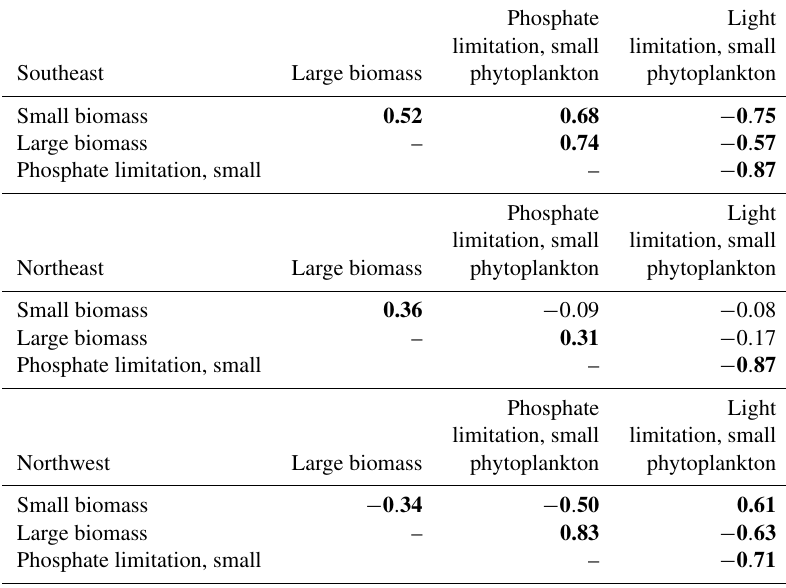
Table 1. Correlations of phosphate and light limitation for small phytoplankton to large and small biomass, 1949–2009. For conciseness, shown here are only small phytoplankton limitation terms, but since these are ratios calculated from identical fields, the correlations are very similar large phytoplankton (Table S1). Bold indicates statistical significance ( p< 0 . 05). Detrending is applied prior to correlation analysis.